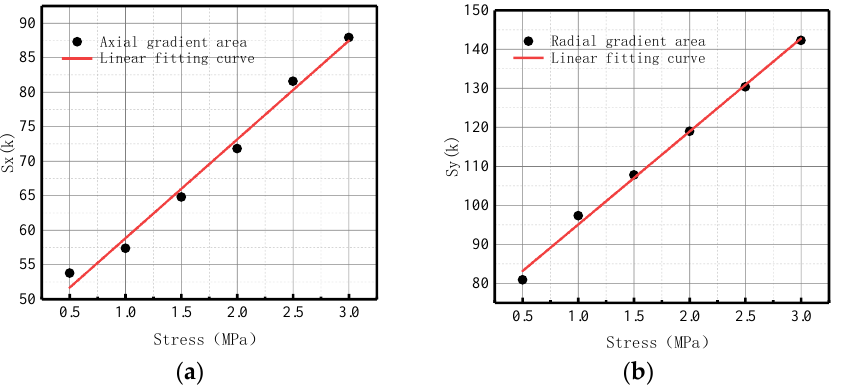
Figure 21. S ( K ) varies with the internal pressure. ( a ) Axial component of S ( k ); ( b ) radial component of S ( k ).